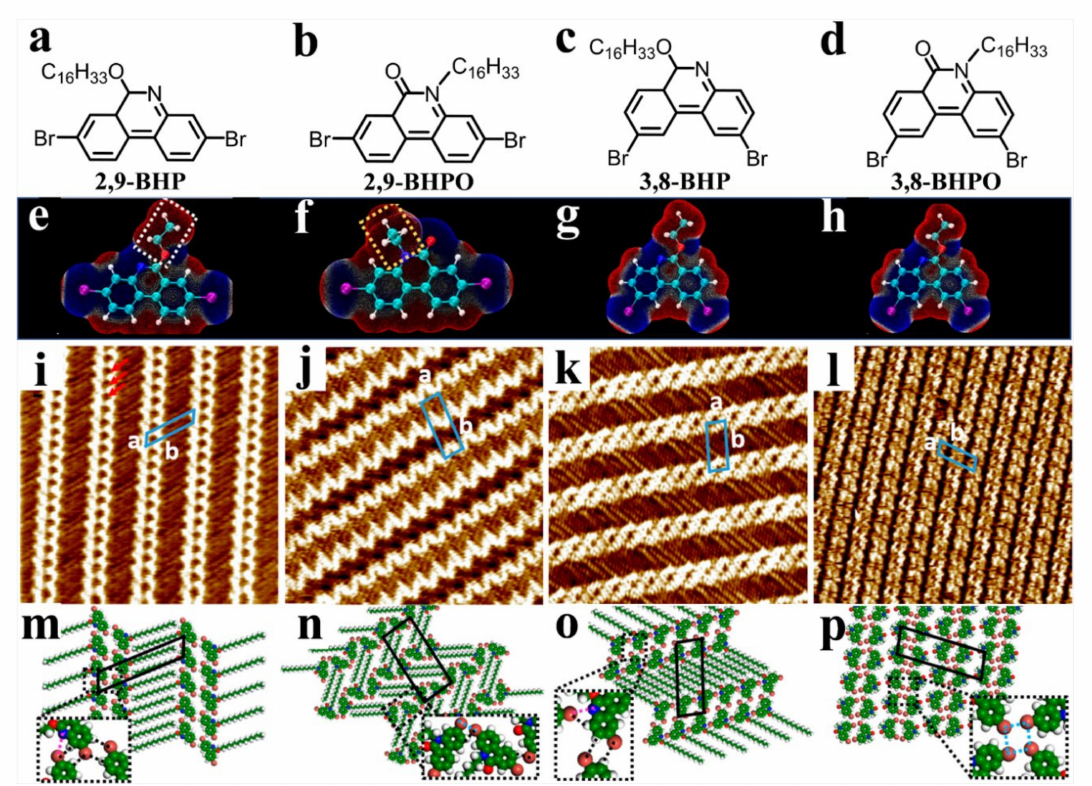
Figure 13. ( a – d ) Chemical structures of 2,9-BHP, 2,9-BHPO, 3,8-BHP, and 3,8-BHPO and their calculated 3D ESP maps ( e – h ). ( i – l ) High-resolution STM images of 2,9-BHP, 2,9-BHPO, 3,8-BHP, and 3,8-BHPO adlayers at the 1-phenyloctane / HOPG interface. ( m – p ) Proposed molecular models of ( i – l ). Image